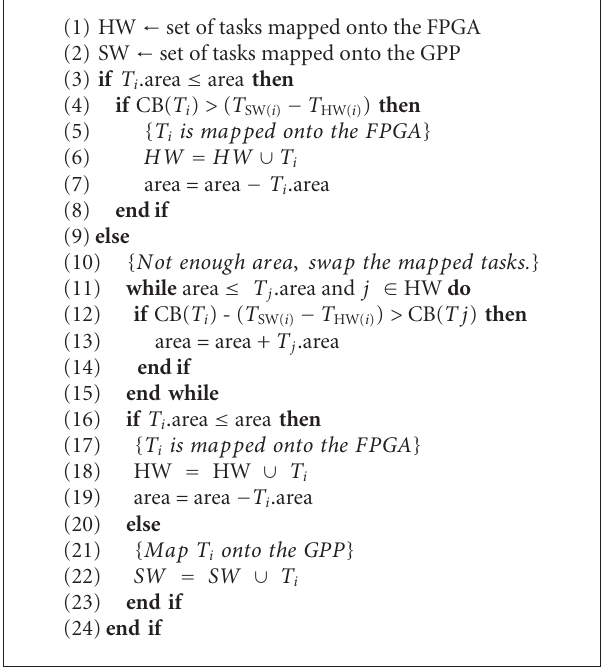
Algorithm 3: Pseudocode for the Interval Based Heuristics (IBH) for the mapping on task T i